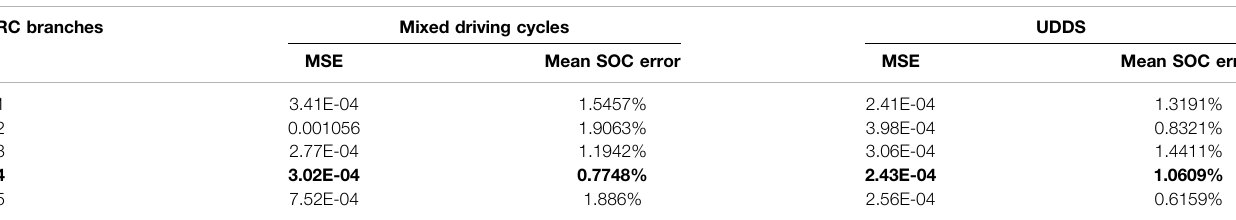
TABLE 16 | Augmented ECM-based AEKF with 20% bias.